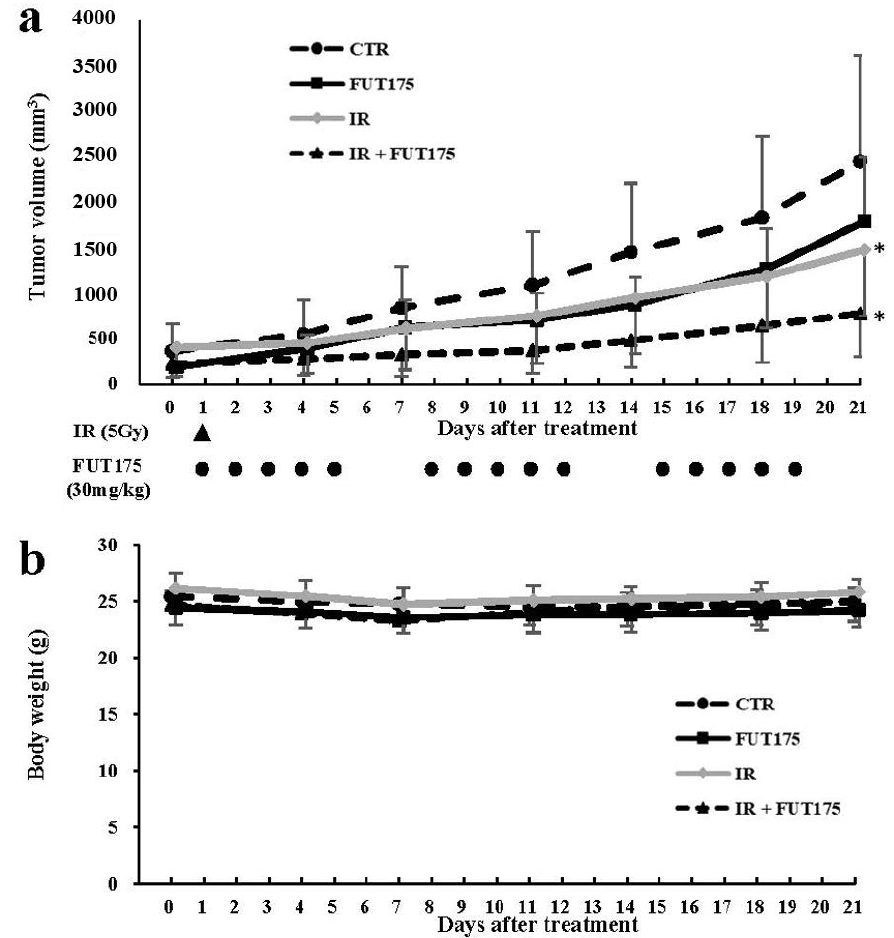
Figure 3. Nafamostat mesilate (FUT175) inhibits tumor growth in SW620 xenograft mice. ( a ) We established a colorectal cancer model by subcutaneously injecting 5 × 10 6 SW620 cells into the right flank of the animals. Three weeks after injection, the animals were randomized into the following groups: FUT175, intraperitoneally injected with FUT175 (30 mg/kg) five times a week; ionizing radiation (IR), intraperitoneally injected with an equal volume of distilled water five times a week and irradiated once (5 Gy); IR + FUT175, intraperitoneally injected with FUT175 (30 mg/kg) five times a week and irradiated once (5 Gy); CTR, intraperitoneally injected with an equal volume of distilled water five times a week. Mean tumor volume was measured at the indicated times after treatment. The largest tumor volume (mm 3 ) measured in the control, FUT175, IR, and combination groups (mean ± standard deviation [SD]) was 2445 ± 1166, 1812 ± 707, 1499 ± 724, and 773 ± 471, respectively. The tumor volume in the combination group was significantly smaller than that in the IR group ( p < 0.05). ( b ) There were no significant differences in the body weights of the animals among the experimental groups. *, p <